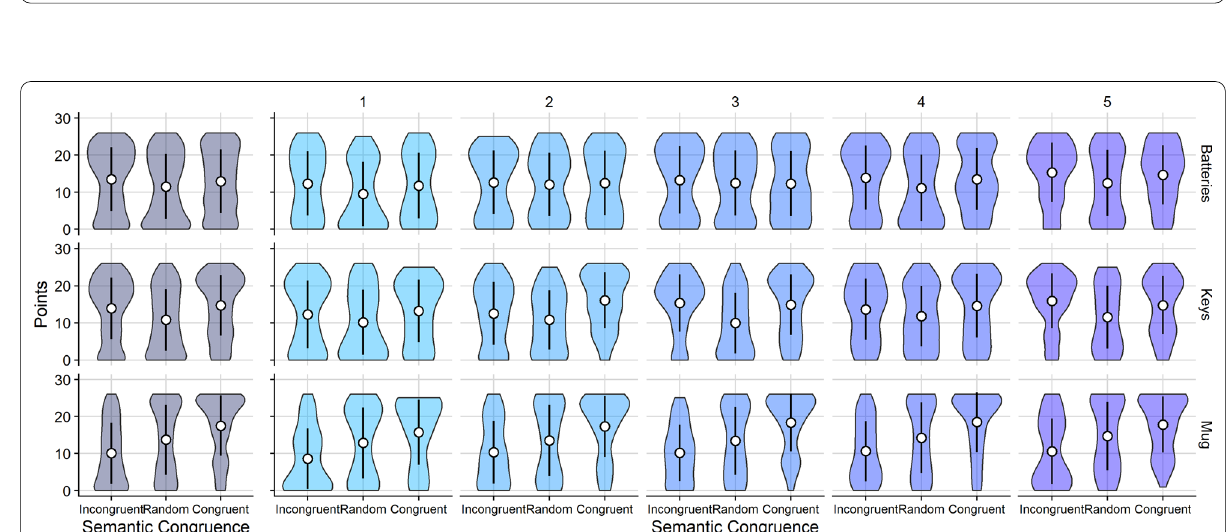
Fig. 13 Violin plots indicating points earned for each target in each semantic congruence condition (left, each violin plot is based on between 487 and 490 observations), and additionally for each session (right, each violin plot is based on between 89 and 100 observations). White circles represent the mean and error bars represent ± 1 standard